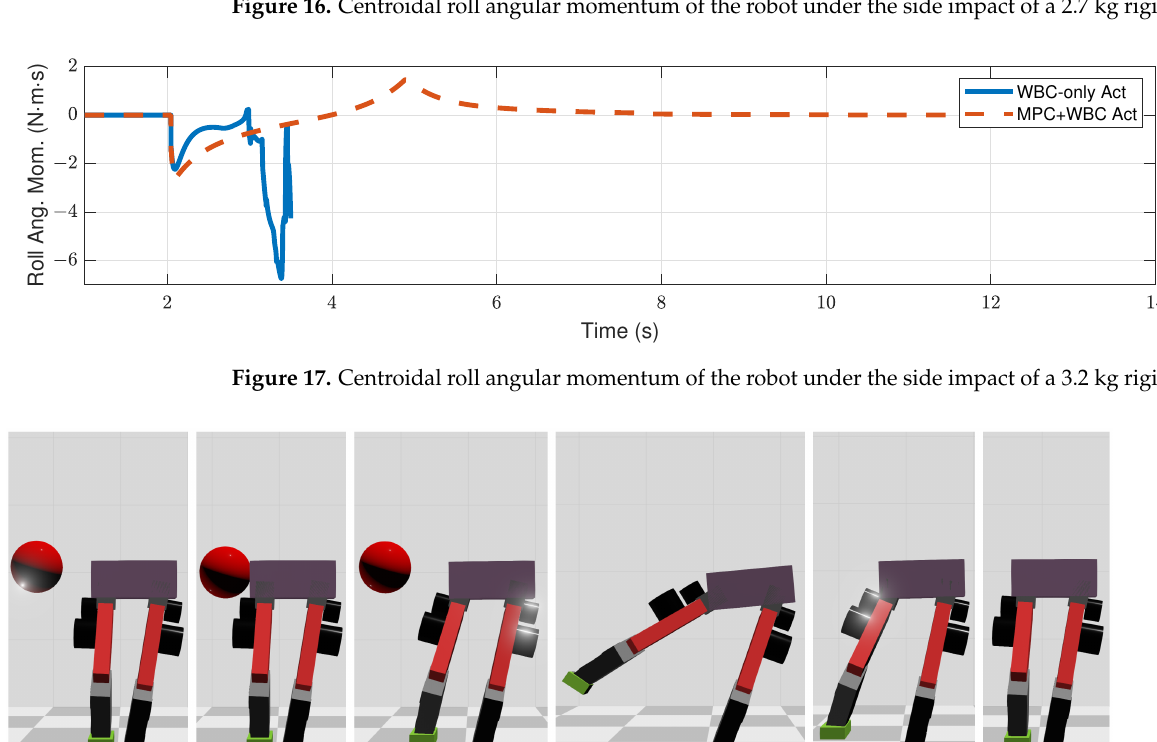
Figure 16. Centroidal roll angular momentum of the robot under the side impact of a 2.7 kg rigid ball.